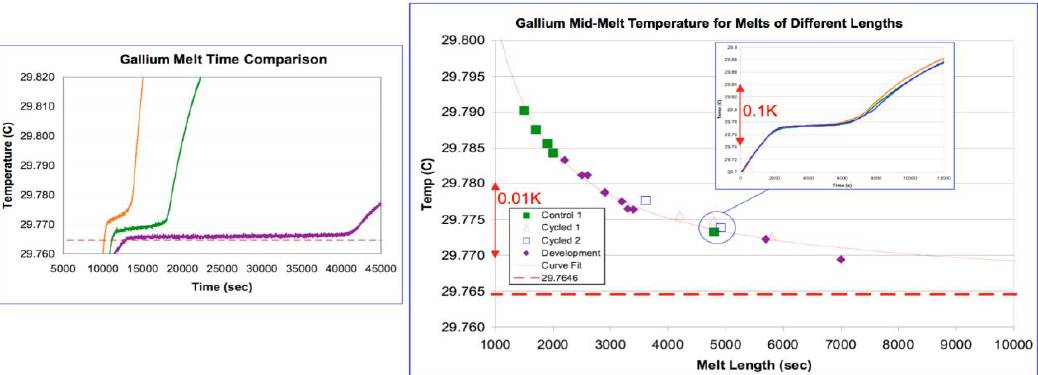
Figure 19. The plot on the left shows three different melts of different duration. The longer the melt the closer the plateau approaches the theoretical melt temperature (indicated with a dashed red line). The large plot at right illustrates this by plotting mid-melt temperature vs. melt length—each data point corresponds to a single melt. The inset plot at upper right shows the three melt signatures associated with the circled data points, indicating great reproducibility.